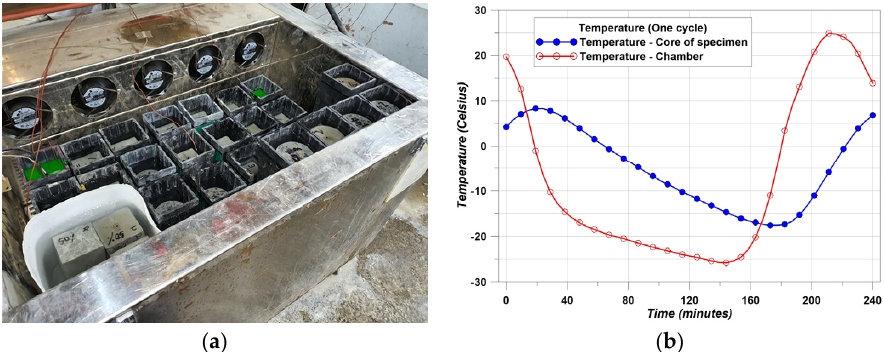
Figure 6. Testing chamber and temperature cycle. ( a ) Freeze-thaw chamber; ( b ) One cycle of temperature.